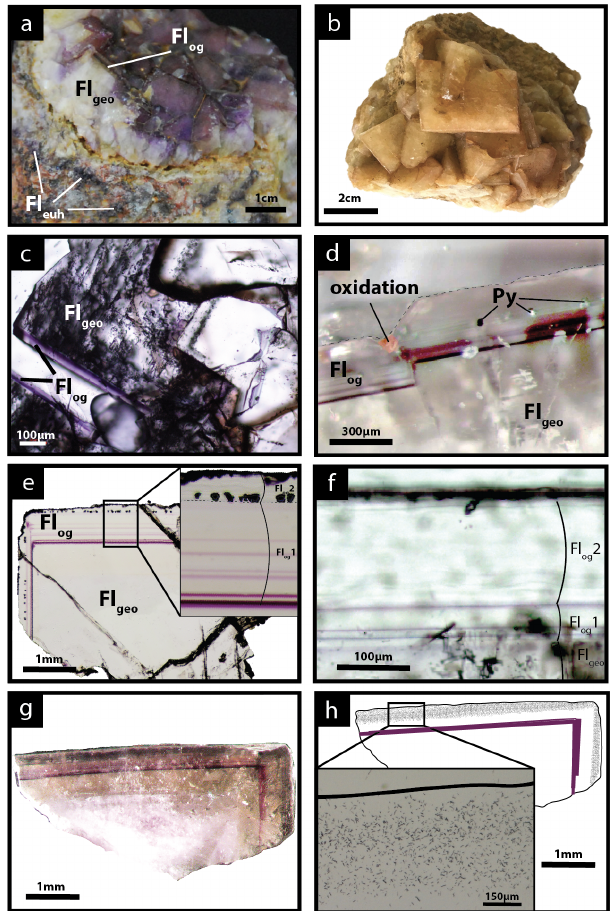
Figure 3. Photographs of the fluorite stages from the Pierre- Perthuis ore. (a) Geode in the altered granite with milky white cu- bic crystals (Fl geo ) and the translucent fluorite overgrowth (Fl og ) delimited by a thin purple band. The euhedral fluorite (Fl euh ) forms patches in the Avallon granite (from Gigoux et al., 2015). (b) Centi- metric cubes of Fl geo , (c) transmitted light microscopy photography of Fl geo and the overgrowth corresponding to Fl og , (d) photography of the limit between Fl geo and Fl og with a pyrite crystal affected by a fracture and oxidized, and (e) transmitted light microphoto- graph of a geodic fluorite crystal with the two stages constituting Fl og : (1) a translucent fluorite initiated by one or several purple rims (Fl og 1) and (2) a final growth stage of laminar fibrous fluo- rite with pyrite inclusions (Fl og 2). (f) Microphotograph in transmit- ted light focused on Fl og 2 showing a laminar texture, (g) photog- raphy in transmitted light of an irradiated crystal of Fl geo + Fl og , and (h) corresponding interpreted map of the induced fission-track distribution in a crystal illustrated in panel (g) with a zoom into the muscovite